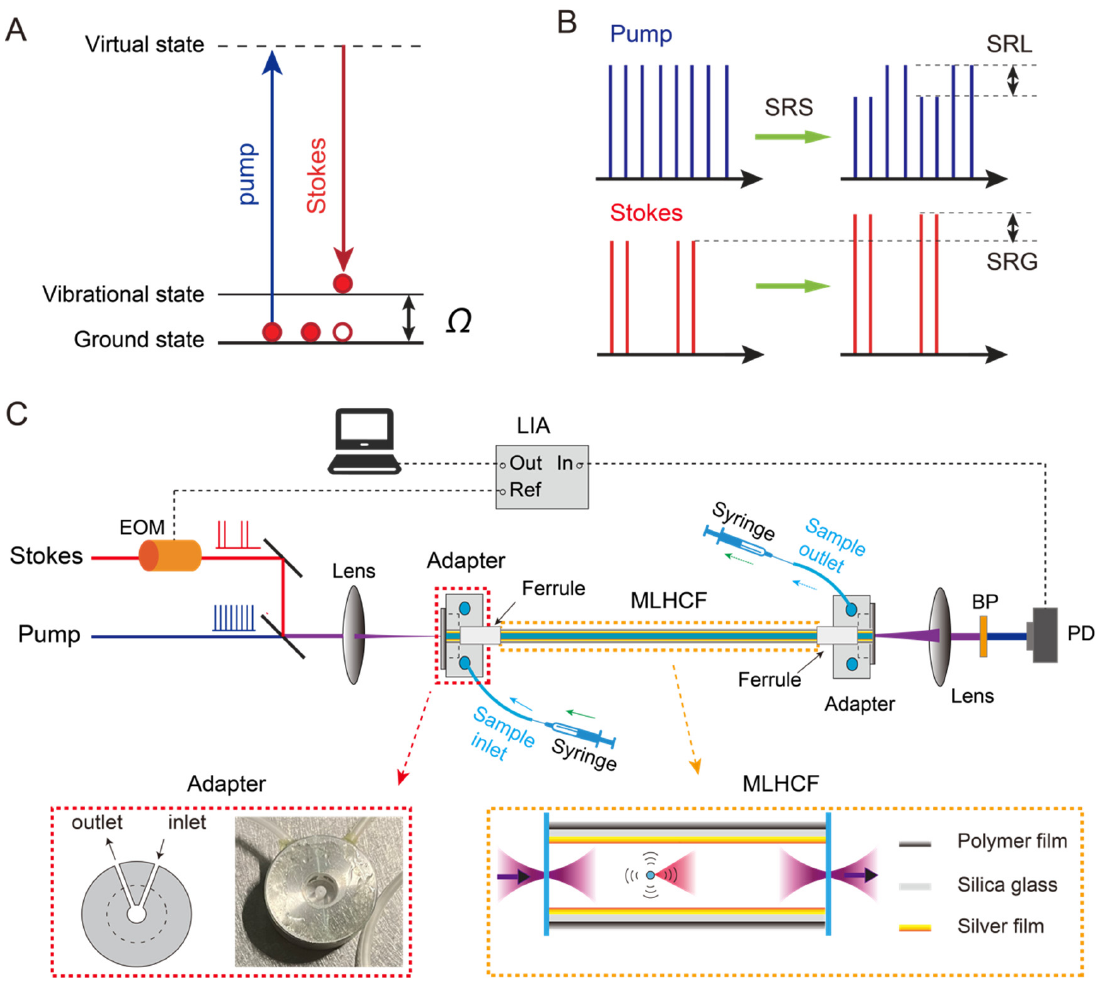
Figure 1. Experimental design: ( A ) energy diagram of stimulated Raman scattering (SRS); ( B ) illustration of the laser intensity changes as a result of stimulated Raman loss (SRL) and stimulated Raman gain (SRG); ( C ) optical layout of the fiber-enhanced stimulated Raman scattering setup. EOM: electro-optic modulator; MLHCF: metal-lined hollow-core fiber; BP: bandpass filter; PD: photodiode; LIA: lock ‐ in amplifier.